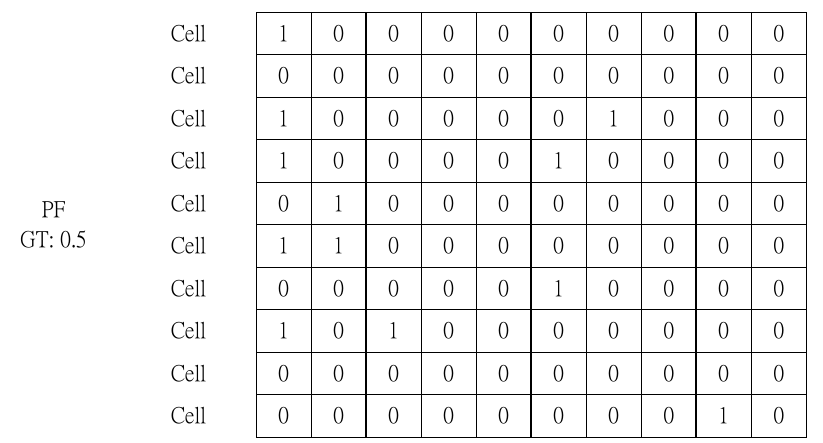
Figure 8. The first PF in XPF that has a GT of 0.5 (A packet whose first byte in a cell is 0 (1) is a control data packet).